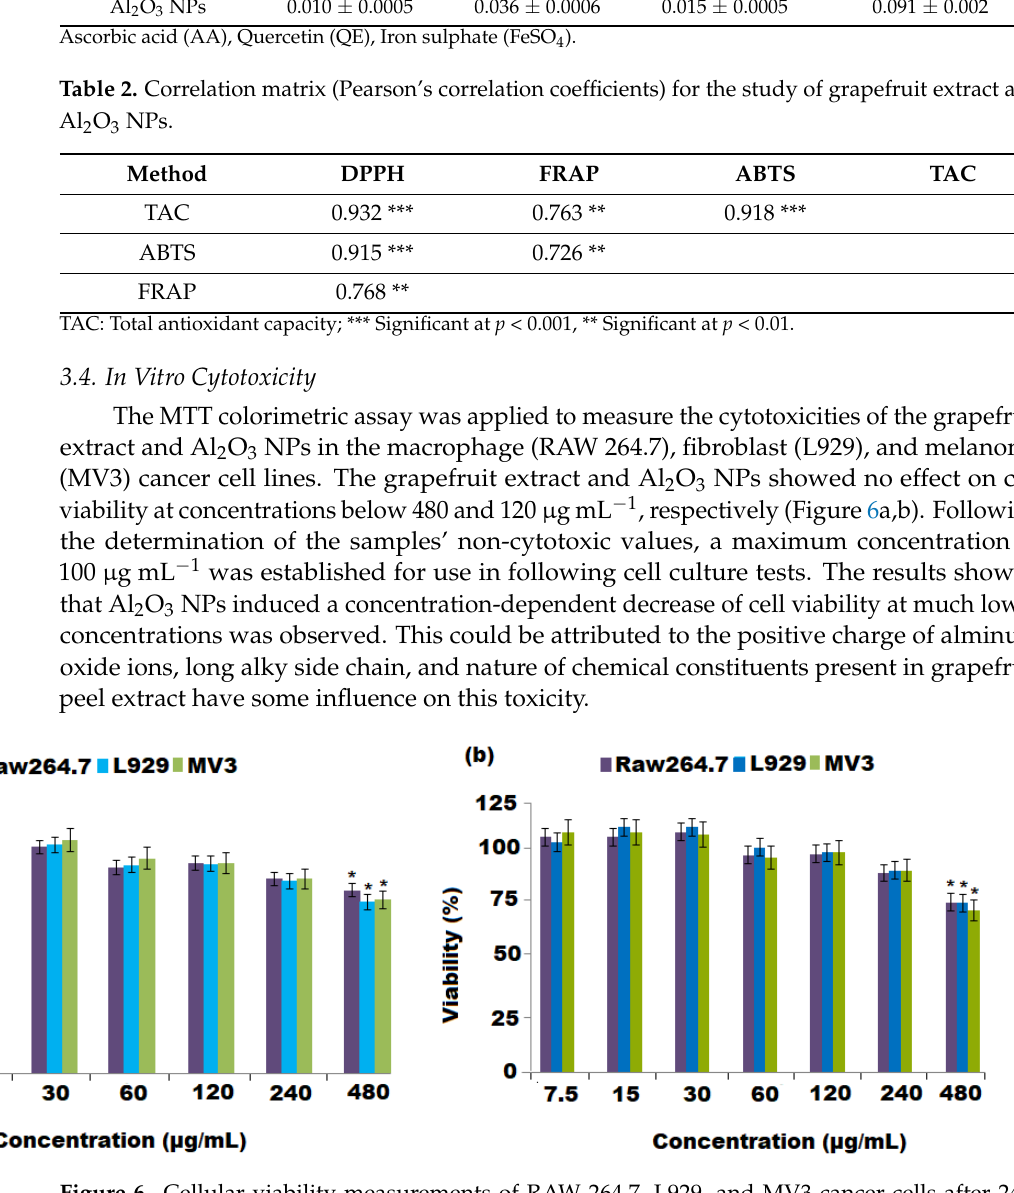
Figure 6. Cellular viability measurements of RAW 264.7, L929, and MV3 cancer cells after 24 h treatment with ( a ) grapefruit peel extract and ( b ) Al 2 O 3 nanoparticles. Values are represented as cellular viability percentage and expressed as the means ± SD of three independent experiments. * Statistically significant ( p < 0.05) as compared to the control cells.